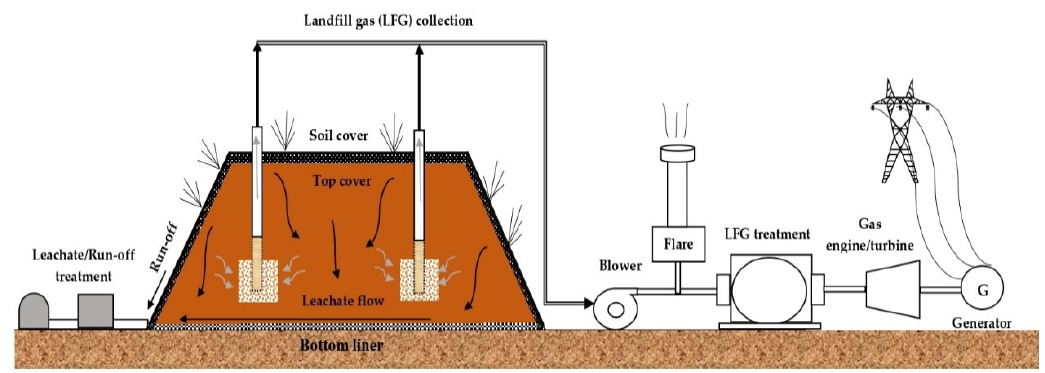
Figure 3. Scheme of landfill gas (LFG) collection and power generation from landfill.